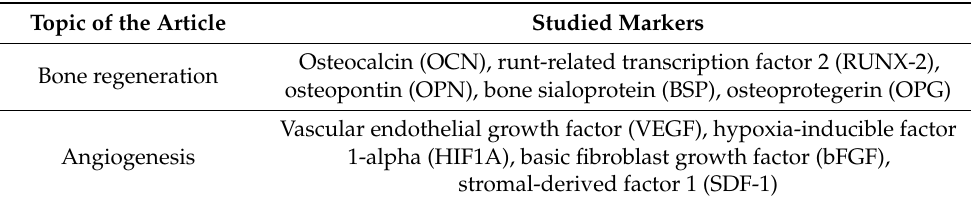
Table 4. Main cell differentiation markers and their application.